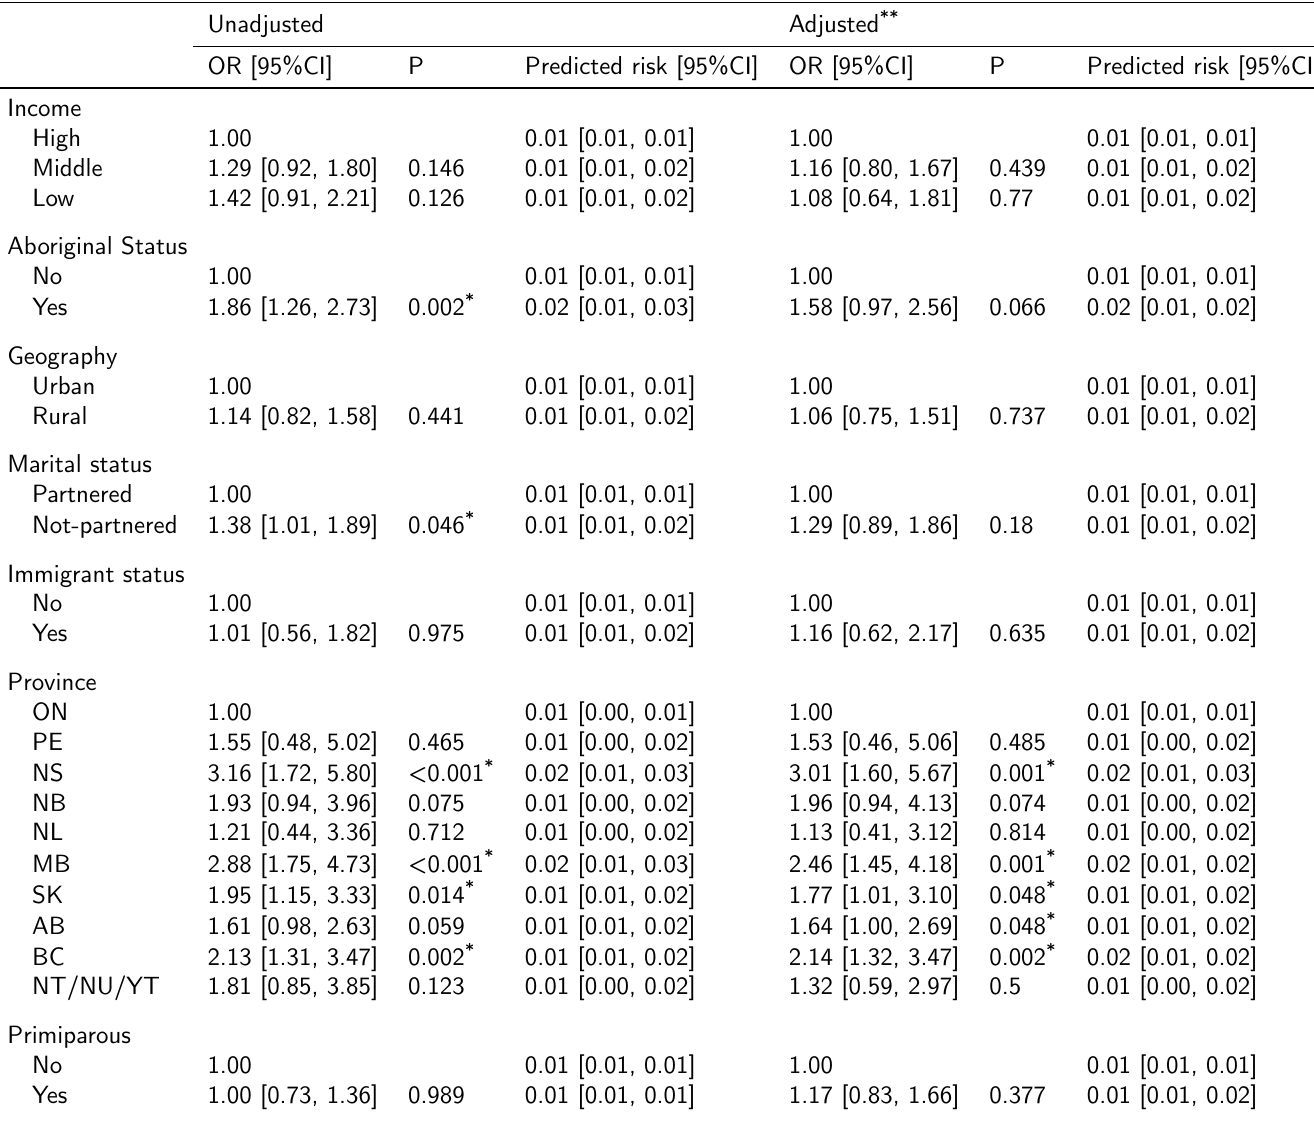
Supplementary Table 6: Odds ratios and risks of maternal readmission within 30 days of delivery Risk of readmission for vaginal delivery (n =